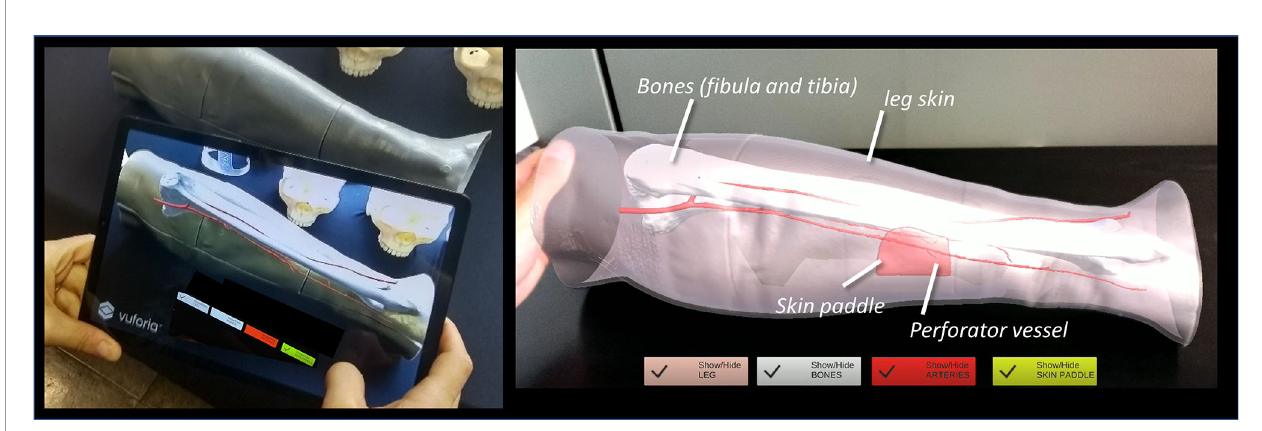
FIGURE 4 | The AR application generating the holographic overlays superimposed on the real phantom anatomy, as displayed to surgeon via tablet.